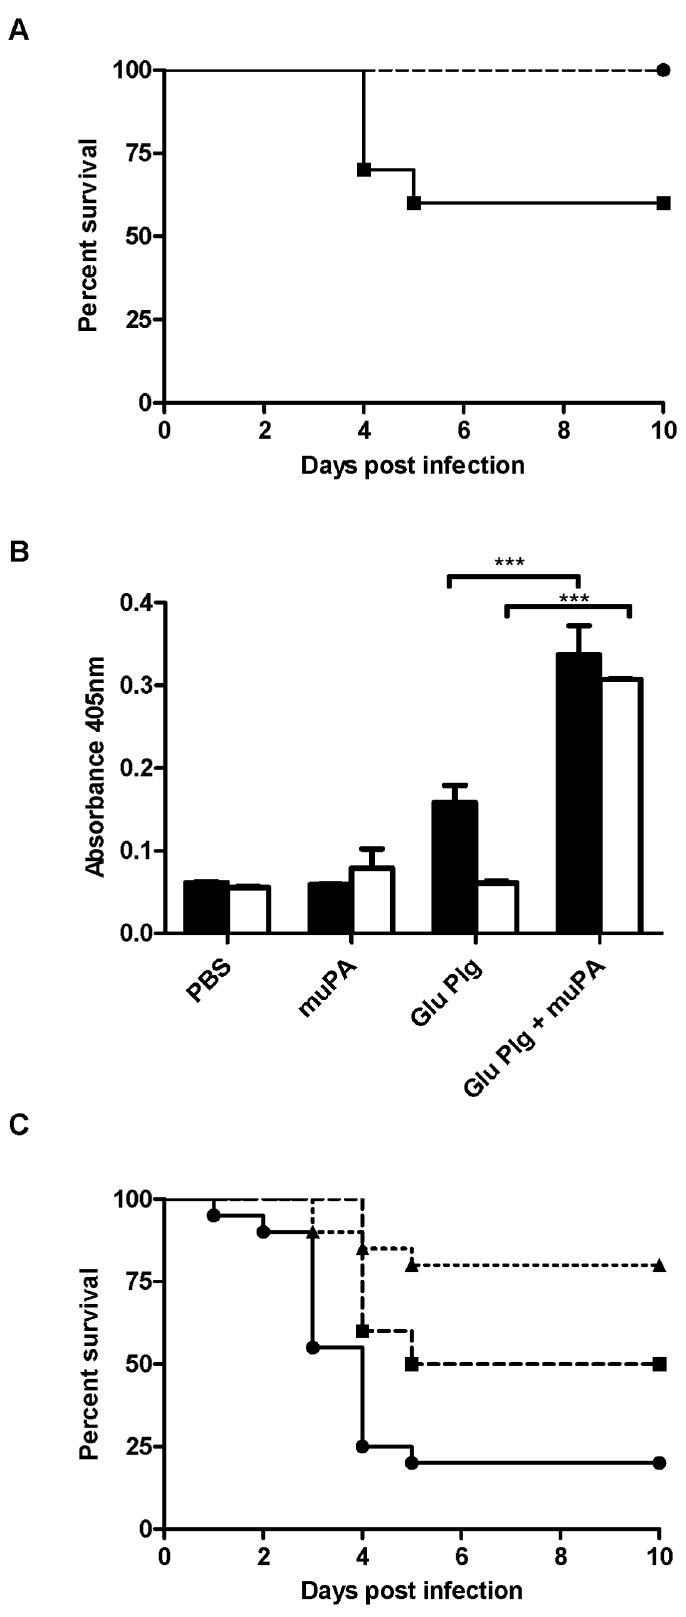
Figure 3. uPA contributes to bacterial disease dissemination invivo . A Cohorts of 10 age and sex matched mice were subcutaneously infected with 1 6 10 9 CFU of GAS strain 5448 or 5448 D ska . C57 black/6J uPA 2 / 2 mice (dashed line) showed a significant increase in survival ( P , 0.05) compared to C57 black/6J mice (solid line). B Mouse uPA can mediate activation of human plasminogen, and human plasmin acquisition by 5448 PLOS Pathogens |